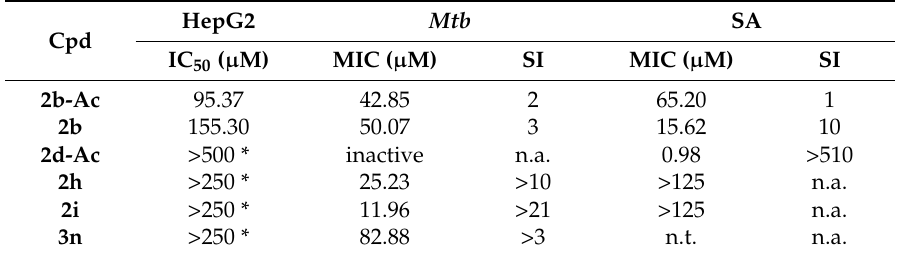
Table 4. In vitro HepG2 cytotoxicity of selected N -pyrazinylbenzamides expressed as IC 50 ( µ M) and their selectivity indexes (SI) for Mtb and S. aureus .